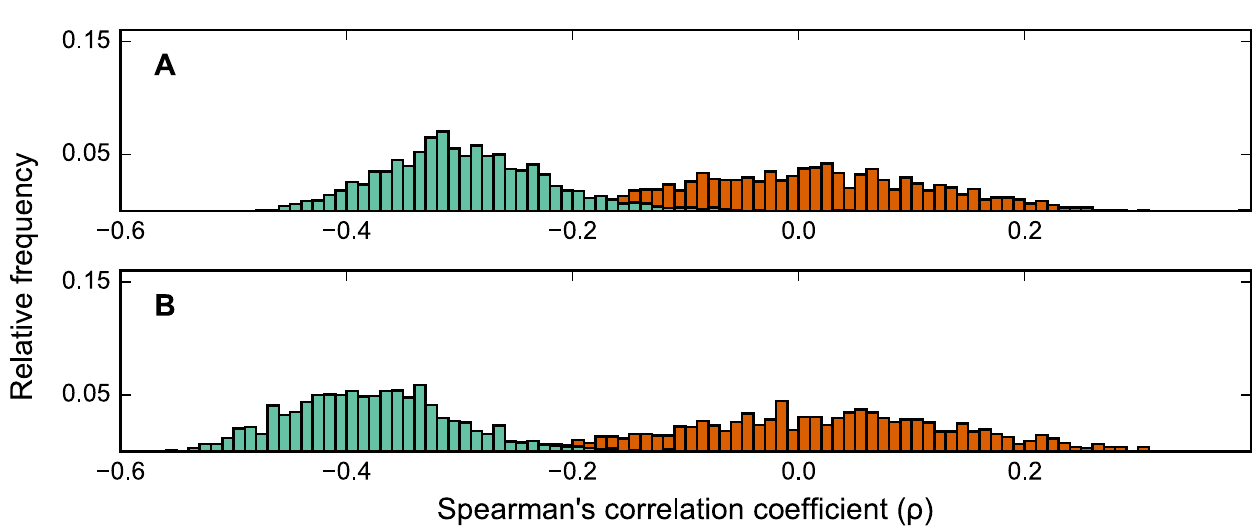
Fig 3. Frequency distributions of (Spearman’s rank) correlations for fast- and slow-evolving isoenzymes. Each isoenzyme in an isoenzyme gene set was categorized as one of: fast-evolving(highest evolutionaryrate within the isozyme set), slow-evolving(lowest rate), or neutral. Plots show distributionsof the correlationwith evolutionaryrate for both function-loss cost and gene-losscost, for: (A) fast-evolving isoenzymes and (B) slow-evolvingisoenzymes.